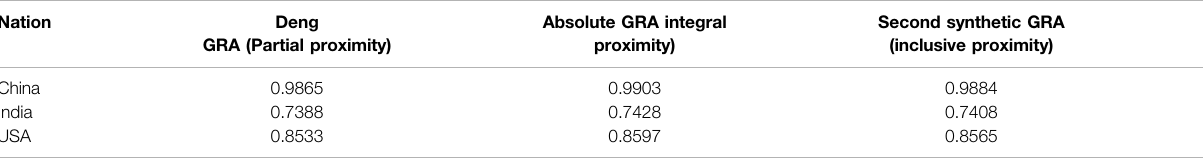
TABLE 2 | Grey relational assessment for wind energy generation and CO 2 emission.